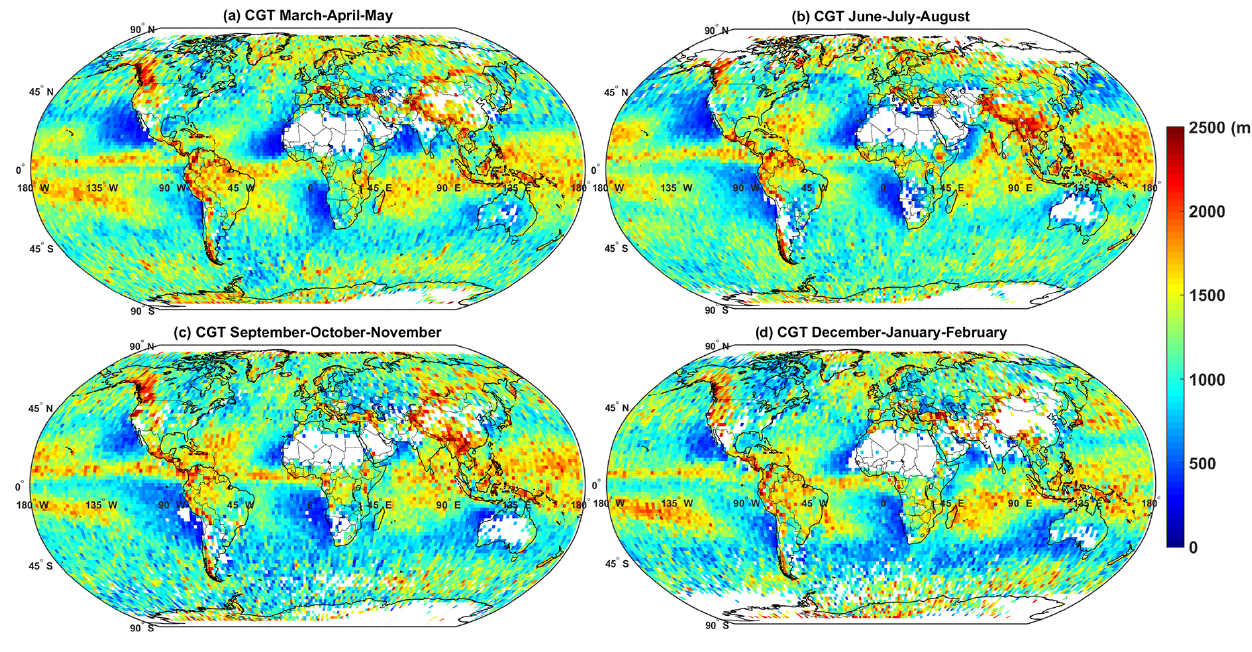
Figure 12. The same as Fig. 10 but for CGT.